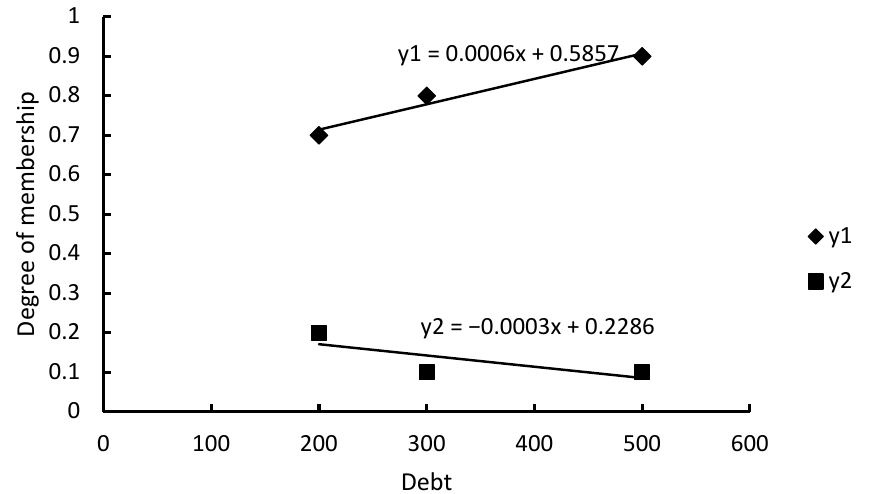
Figure A17. Single factor evaluation for the index of debt (more than 200 ten thousand yuan).